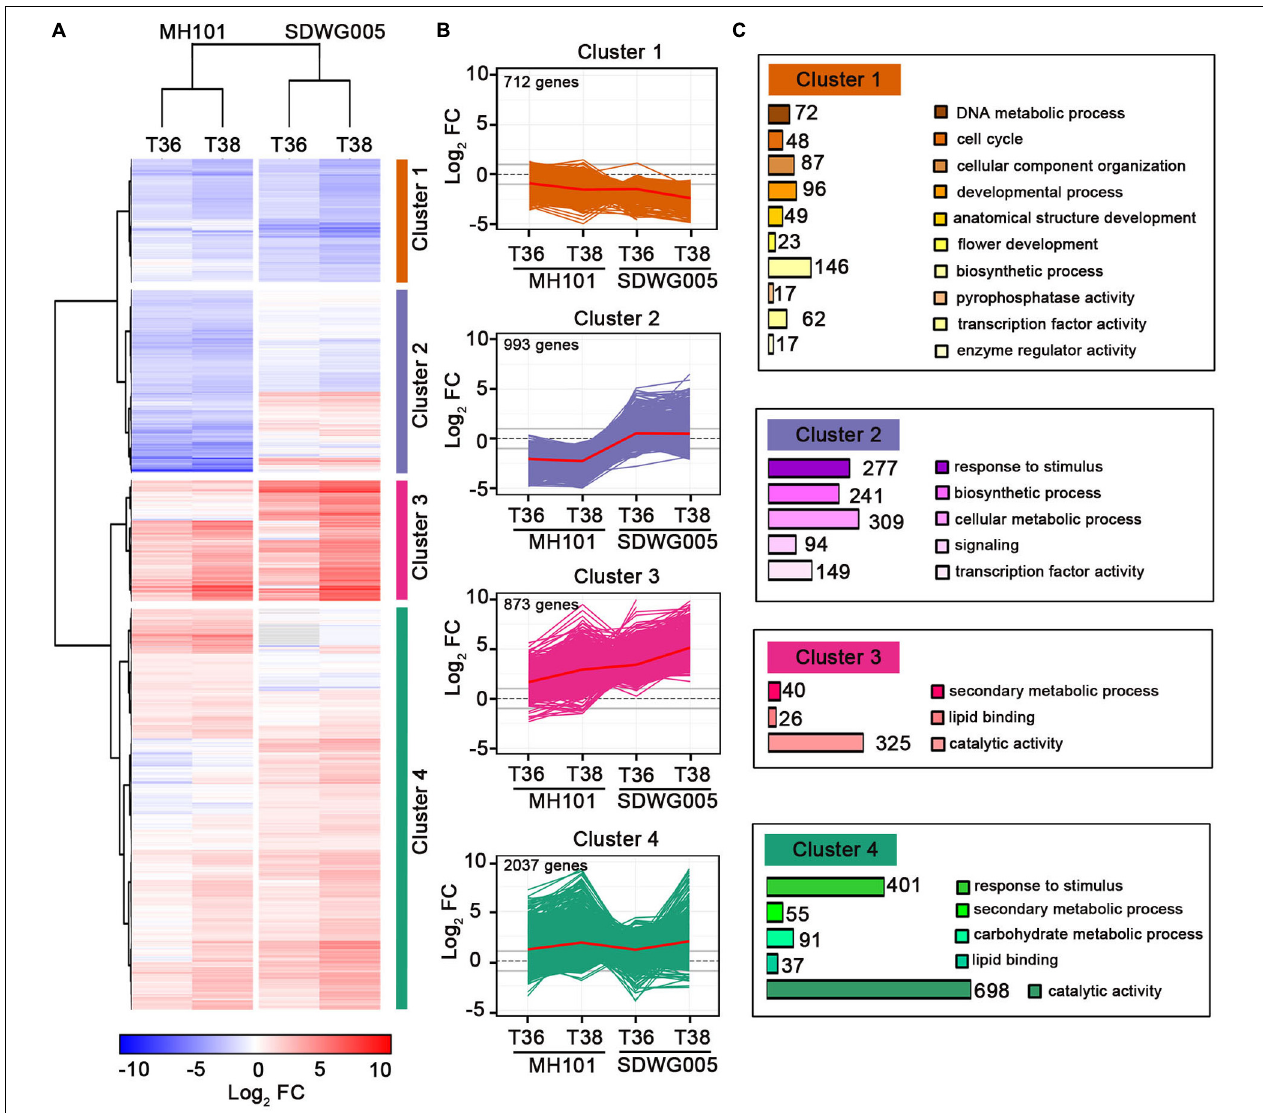
FIGURE 4 | Global patterns of gene expression during heat stress. (A) Hierarchical clustering analysis to reveal the transcript expression patterns of DEGs in MH101 and SDWG005 spikelets subjected to different high temperature treatments (T36 or T38). Colored bars show the fold changes of gene expression under T36 and T38 treatments compared to their corresponding controls. (B) Gene expression profiles in clusters 1, 2, 3, and 4 as indicated. Lines reflected expression changes for each DEGs across different treatments. The mean changes of expression in each cluster are shown with a red line. (C) GO categories of DEGs enriched in each cluster. The number show the DEGs enriched in each GO